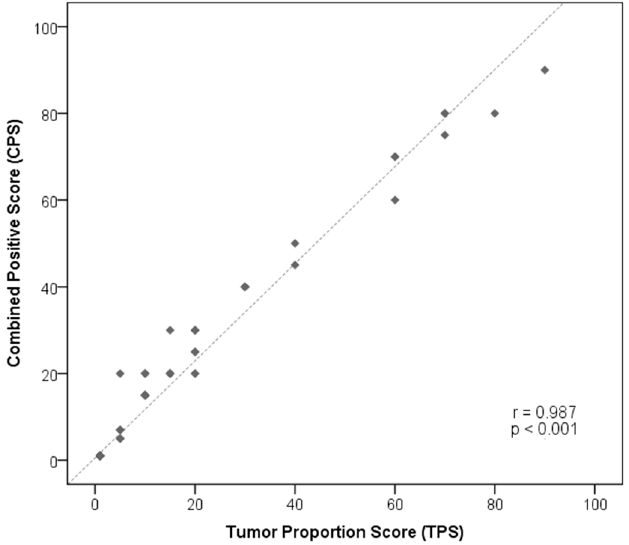
Figure 2. Detection of PD ‐ L1 expression by IHC using the E1L3N antibody, with an optical magni ‐ fication of 200×. Representative images of PD ‐ L1 ‐ ( a ) negative and ‐ ( b ) positive expressions are shown.